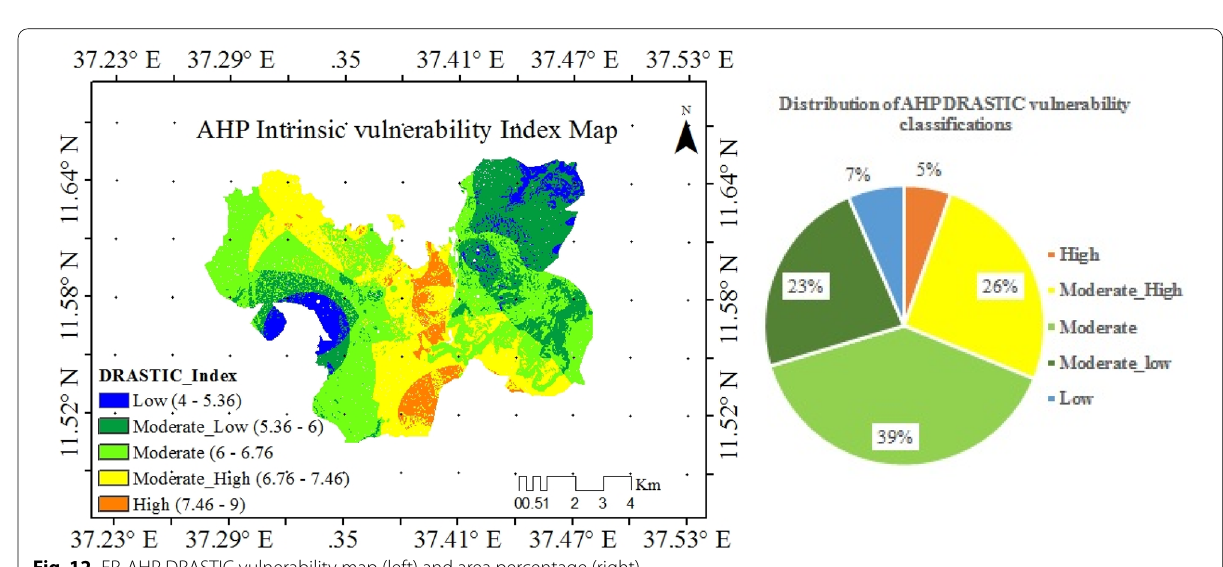
Fig. 12 FR-AHP DRASTIC vulnerability map (left) and area percentage